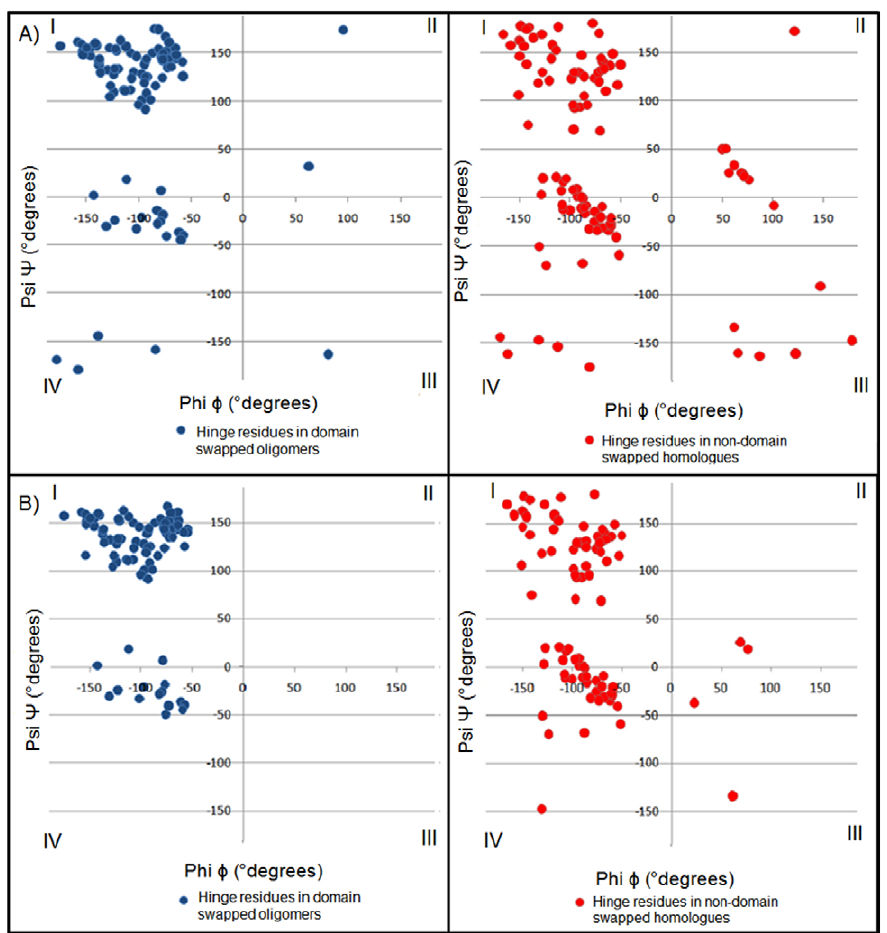
Figure 4. Backbone conformation of hinge regions in domain swapped oligomers. A) ( Q , y ) conformation distribution of all hinge residues. B) ( Q , y ) conformation distribution of non-glycine hinge residues.